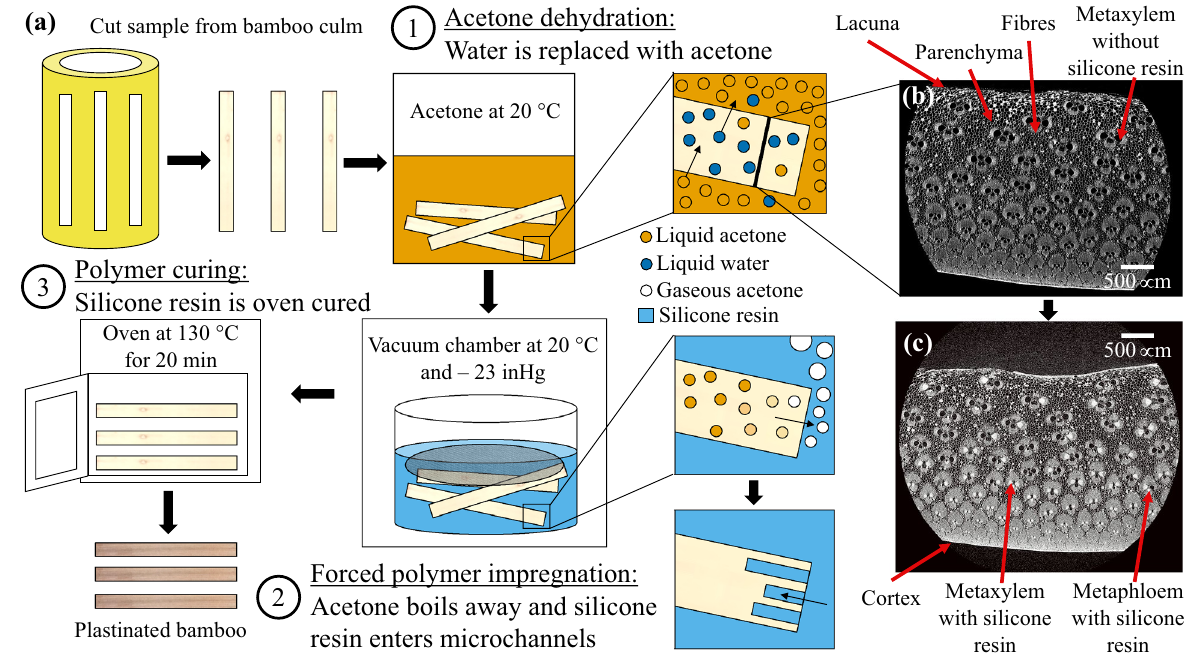
Figure 1. ( a ) The three main steps in the improved (final recommended) plastination method: acetone dehydration, forced polymer impregnation, and polymer curing. Micro-CT images on the right show the microstructure of a bamboo specimen’s cross-section ( b ) before and ( c ) after